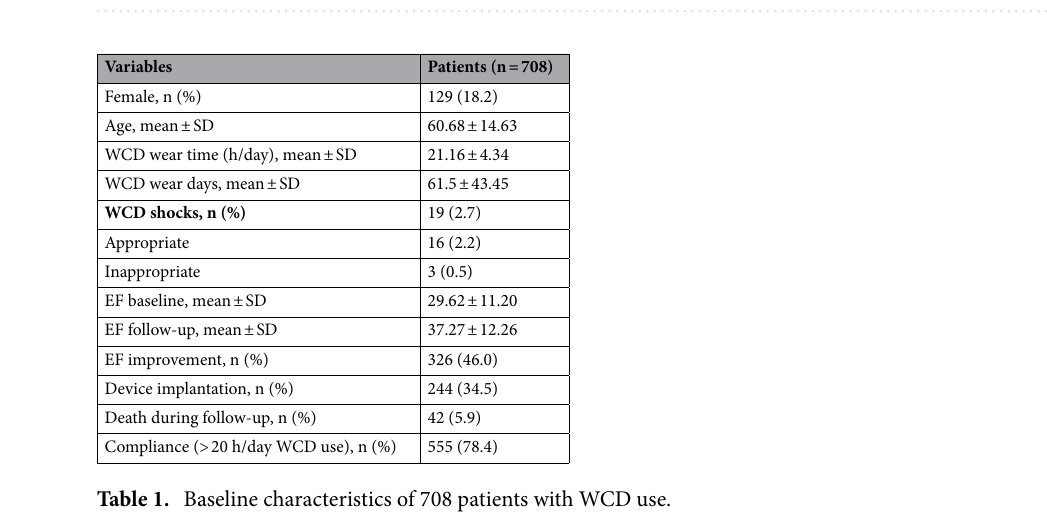
Figure 1. The distribution of indication for WCD us in the general cohort.